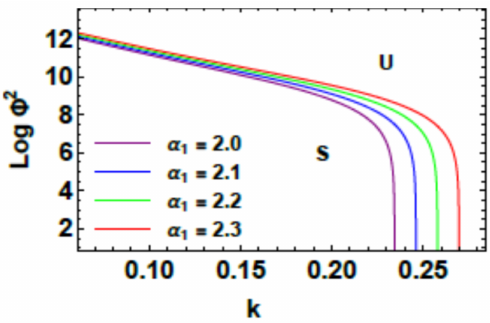
Figure 8. Plots of the stability bound for α 1 for different values the parameter k versus Log Φ 2 .